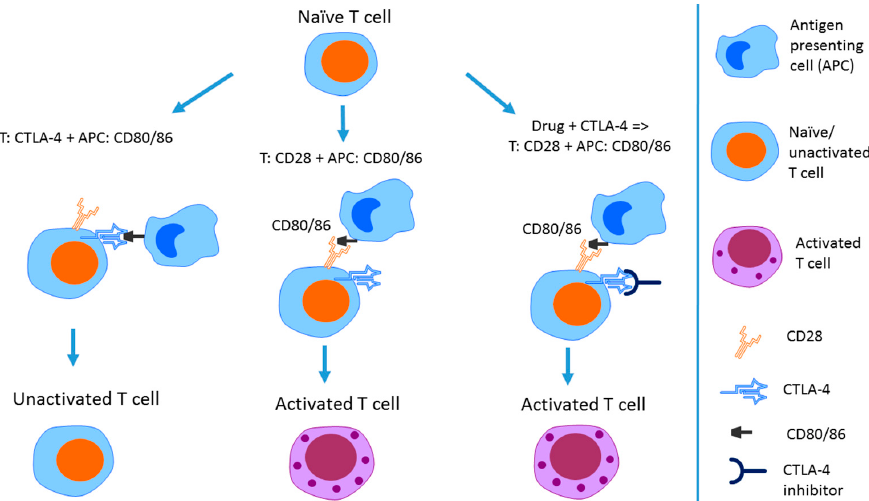
Figure 2. Mechanism of action of CTLA ‐ 4 checkpoint inhibitor. CTLA ‐ 4 and CD28 are receptors expressed on the T cell surface; CD80/86 are receptors on the surface of antigen ‐ presenting cells (APCs). When CTLA ‐ 4 comes in contact with CD80/86 receptors, the T cell remains unactivated. Interaction of CD28 on T cell surface with CD80/86 on the APC cell surface results in T cell activation. Pharmacological blocking of CTLA ‐ 4 on the T cell surface increases the likelihood of CD28–CD80/86 binding, resulting in maintenance of T cell activation. Figure is adapted with permission from [26].